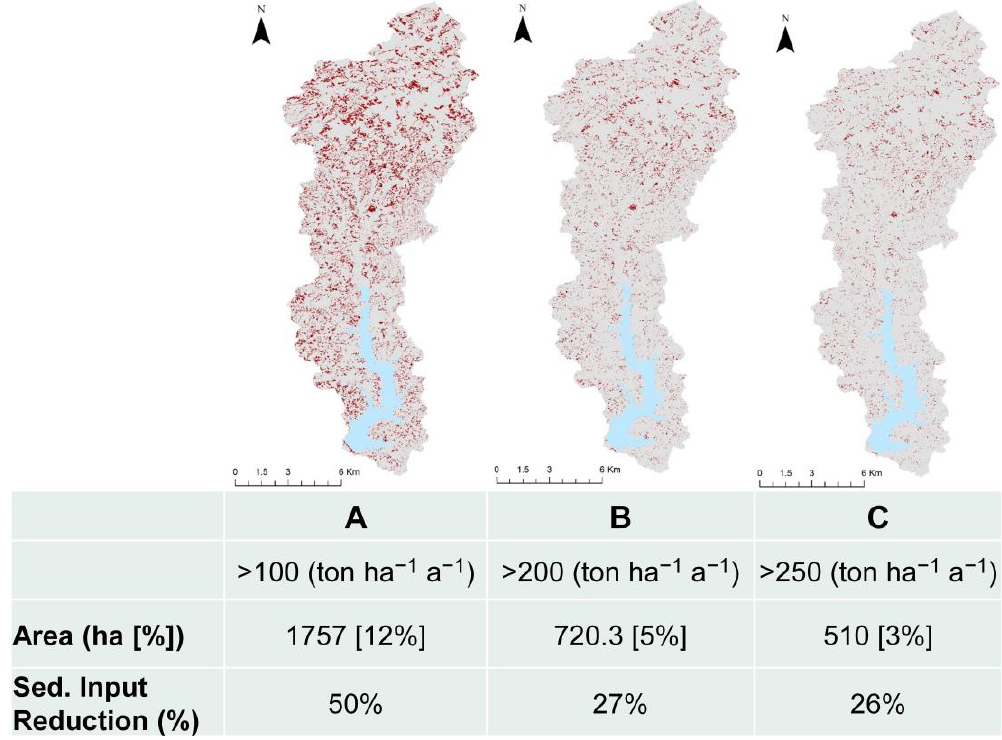
Figure 25. Areal coverage of problematic areas for scenarios ( A ), ( B ), and ( C ) and the respective reduction of sediment input from afforestation. The area in percentage refers to the percentage of the catchment that each management scenario affects.